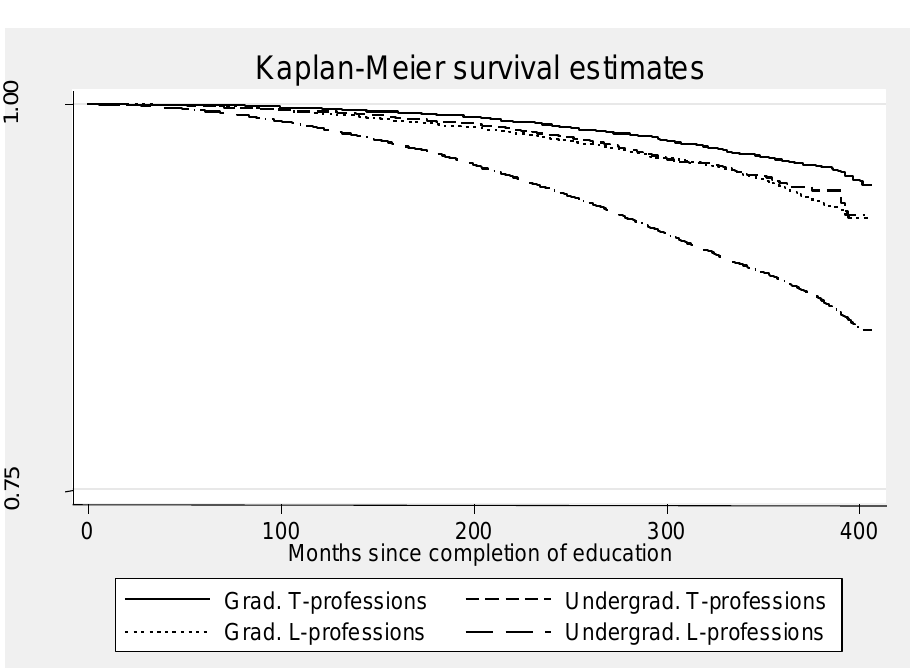
Figure 1. Survival function for the four types of professions (Grad. L-professions = graduate life professions; Grad. T-professions = graduate thing professions; Under- grad. L-professions = undergraduate life professions; Undergrad. T-professions = undergraduate thing professions). Norway, 1992–2008. N = 341,856. The scale of the y-axis is cut to vary between 0.75 and